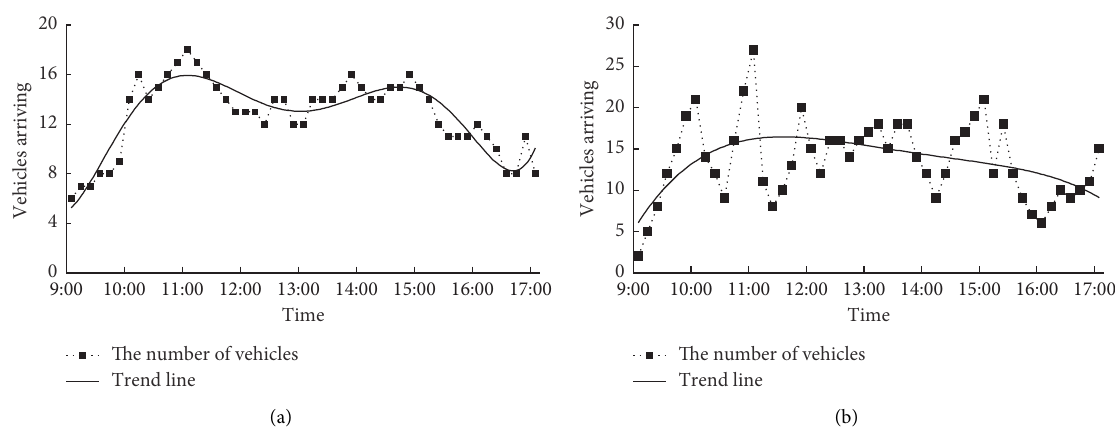
Figure 4: The changes of vehicle arriving between commercial zones. (a) Le Song Plaza. (b) Song Lei commercial building.